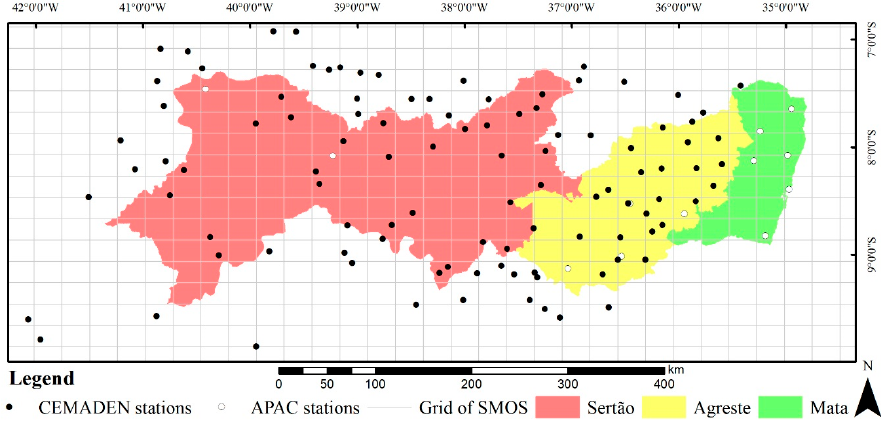
Figure 2. Spatial distribution of soil moisture stations in Pernambuco state and the grid of the Soil Moisture Ocean Salinity (SMOS) satellite.